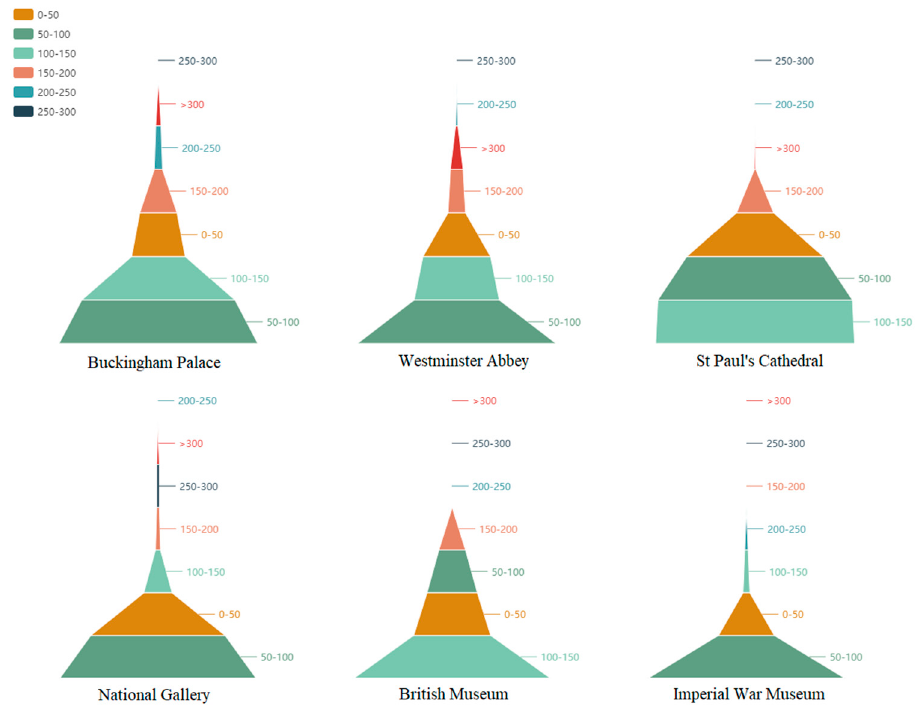
Figure 11. Count-distribution visualization of each distance layer. The wider the layer is, represents the more images were distributed within the corresponding range.